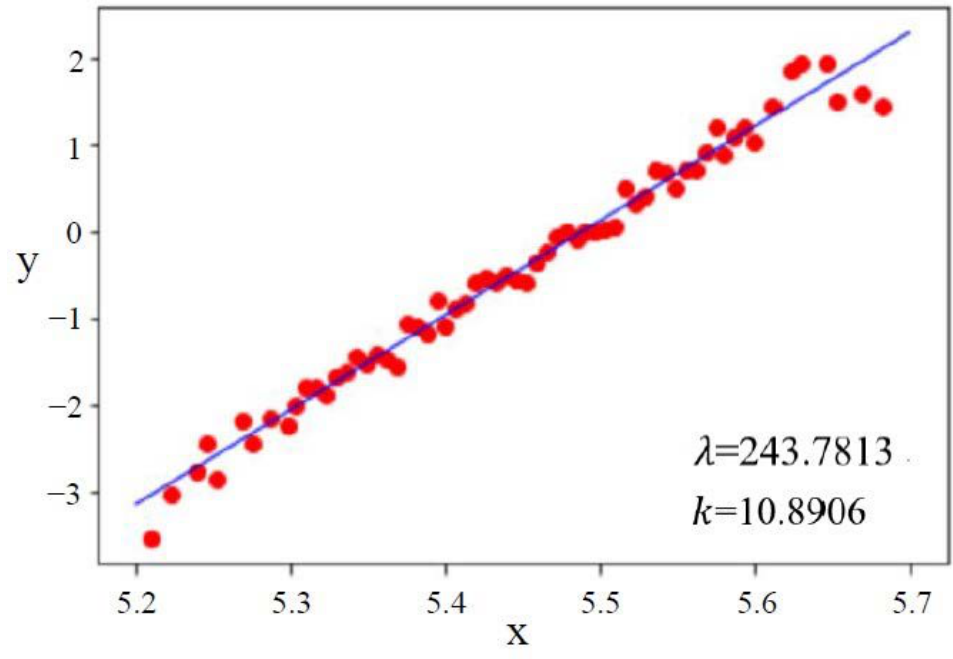
Figure 5. Least squares fitting